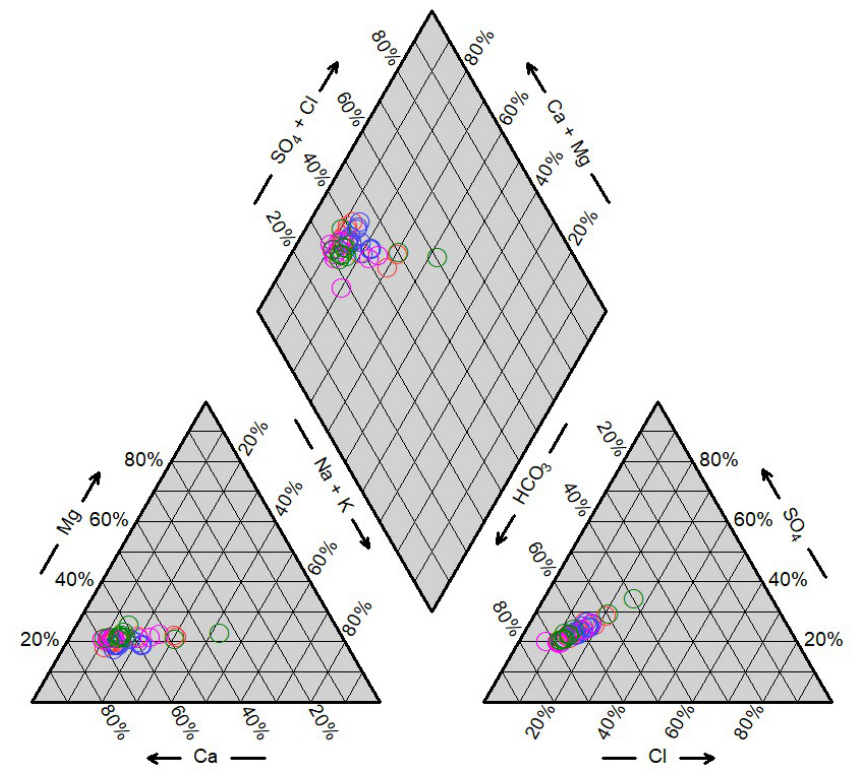
Figure 5. The Piper Diagram of spring water samples. (The red circle is for Baotu Spring, the blue circle is for Heihu Spring, the violet circle is for Wulong Spring, and the green circle is for Zhenzhu Spring).